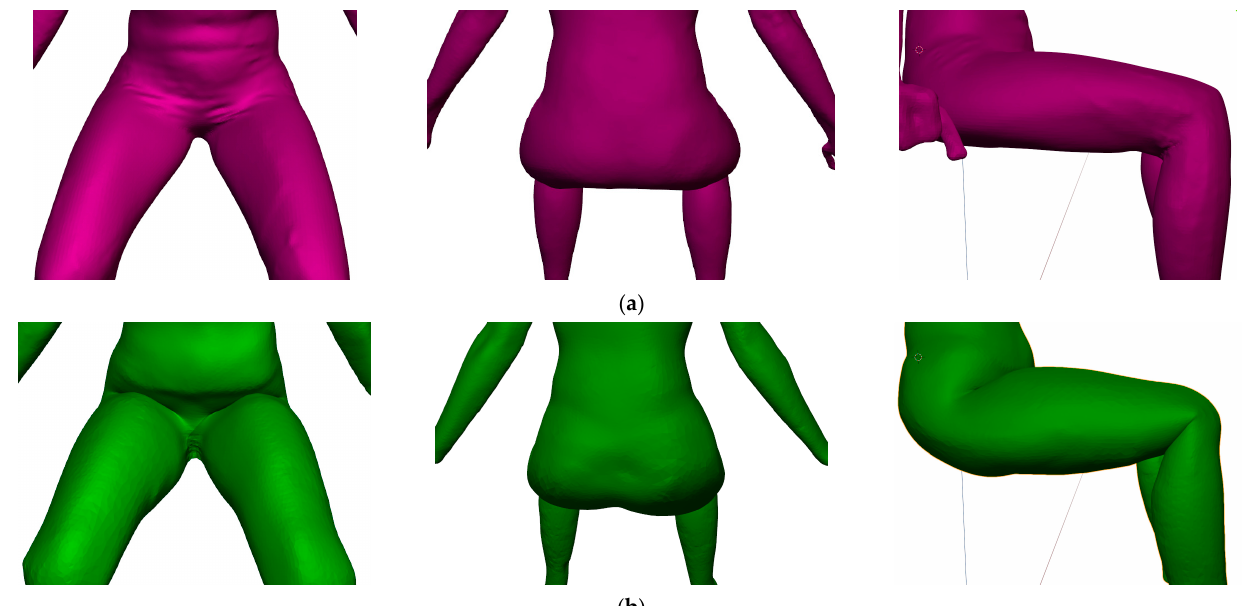
Figure 8. Comparison of joints regions: ( a ) scanned sitting 3D body model (purple), ( b ) kinematic sitting 3D body model (green).